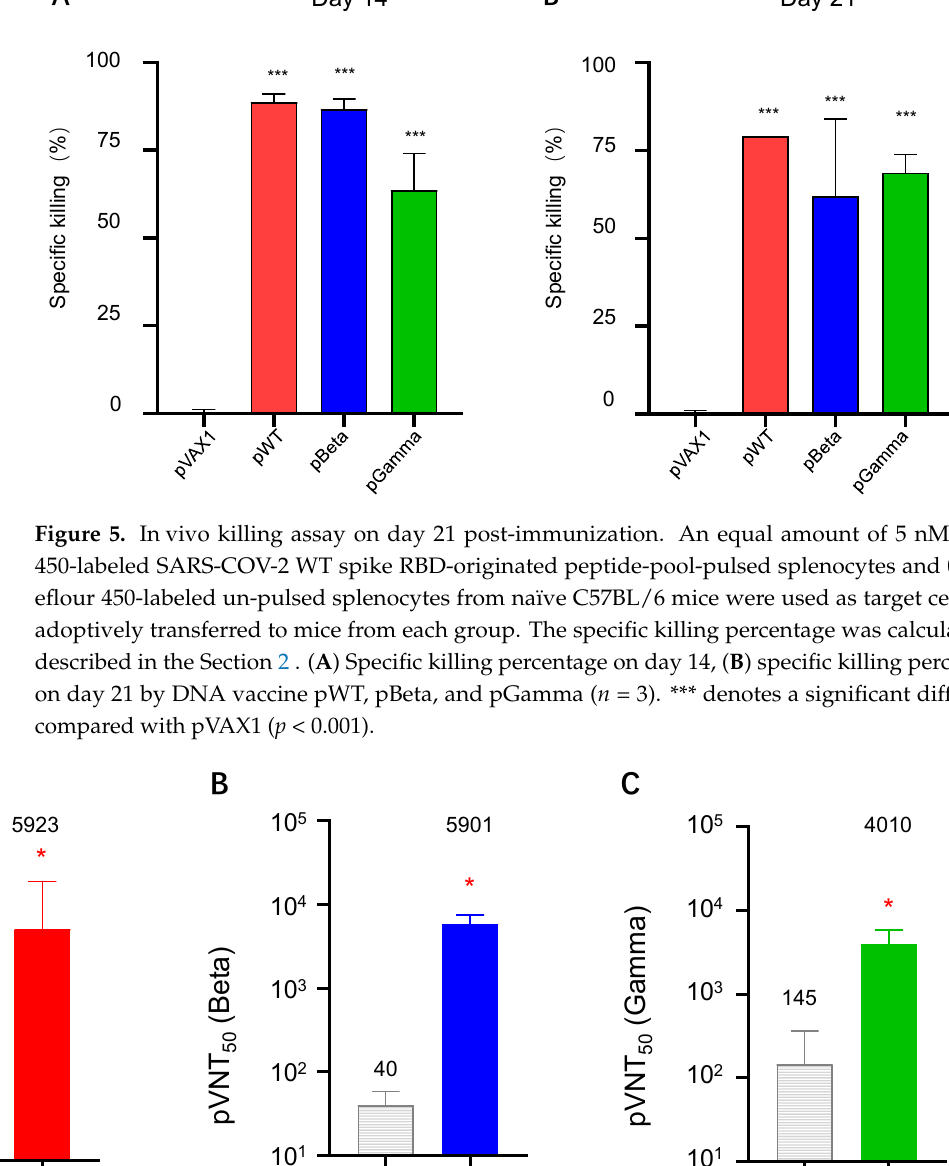
Figure 6. Neutralizing antibodies in mouse sera were detected via pseudo-virus neutralization on day 21. Sera from immunized mice were three-fold serially diluted starting at 1:30. Neutralization titers were calculated using GraphPad Prism 9.0 and defined as the reciprocal serum dilution at which RLU was reduced by 50% compared to virus control and expressed as geometric mean ± SD. ( A ) Serum pVNT 50 to wild type SARS-CoV-2 by pWT ( n = 4), ( B ) serum pVNT 50 to SARS-CoV-2 variant Beta by pBeta ( n = 4), ( C ) serum pVNT 50 to SARS-CoV-2 variant Gamma by pGamma ( n = 4). * denotes a significant difference compared with pVAX1 ( p < 0.05).